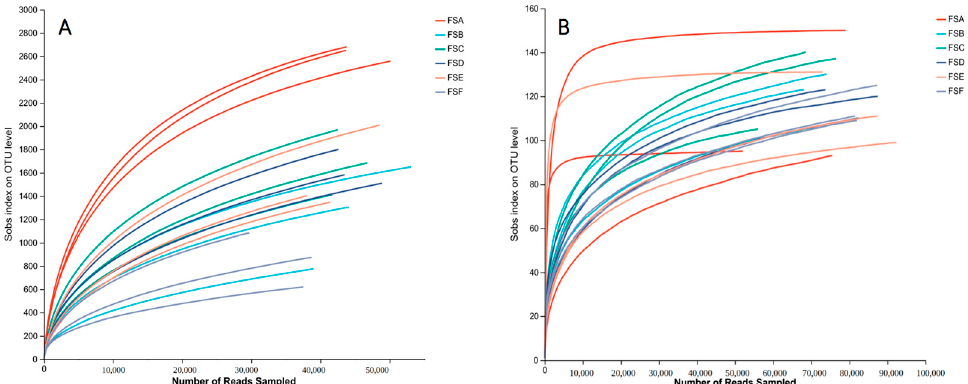
Figure 2. Bacterial and fungal rarefaction curves of different soil treatments. Note: ( A ) rarefaction curve of bacterial community; ( B ) rarefaction curve of fungal community. FSA, FSB, FSC, FSD, FSE, and FSF represent saline-alkali soil samples with GLR organic fertilizer addition ratio of 25%, 16.7%, 12.5%, 10%, 8.3%, and 0%, respectively.